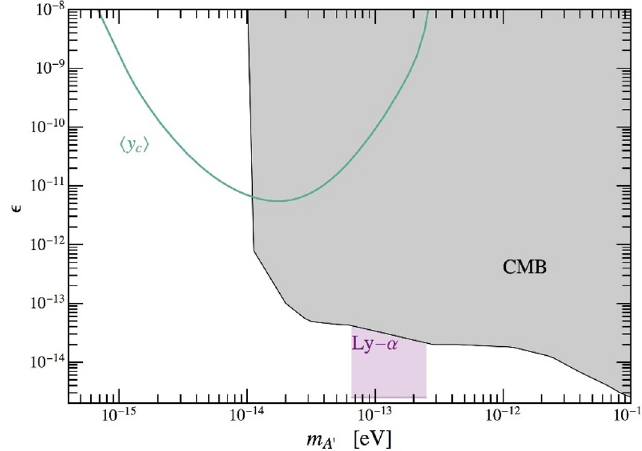
Figure 11 . Projected sensitivity for an experiment like PIXIE or PRISIM capable of measuring spectral distortions to a level of y (cid:24) 10 (cid:0) 7 . Constraint is derived assuming reionization has not yet begun by z (cid:24) 10, and dark photons supply the only source of